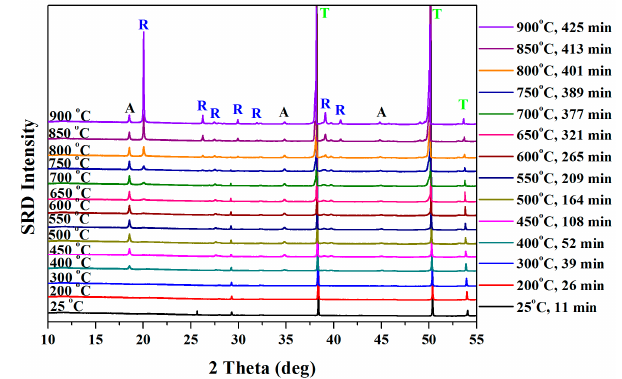
Figure 4. Stacked in-situ high-temperature SRD plot for as-anodized titania nanotube arrays obtained at ambient temperature; in 100 °C steps from 100 to 300 °C; and 50 °C steps from 400 to 900 °C at 10 °C/min, 2 min/pattern data-acquisition time [Ti: titanium, A: anatase, and R: rutile]. Relative analysis was used to calculate the relative phase levels of titanium- α , titanium- β , crystalline anatase, and crystalline rutile in the anodized nanotube arrays. The residual values for the Topas refinements R wp and R exp were ~9 and 2, respectively. The goodness-of-fit, X 2 , ranged